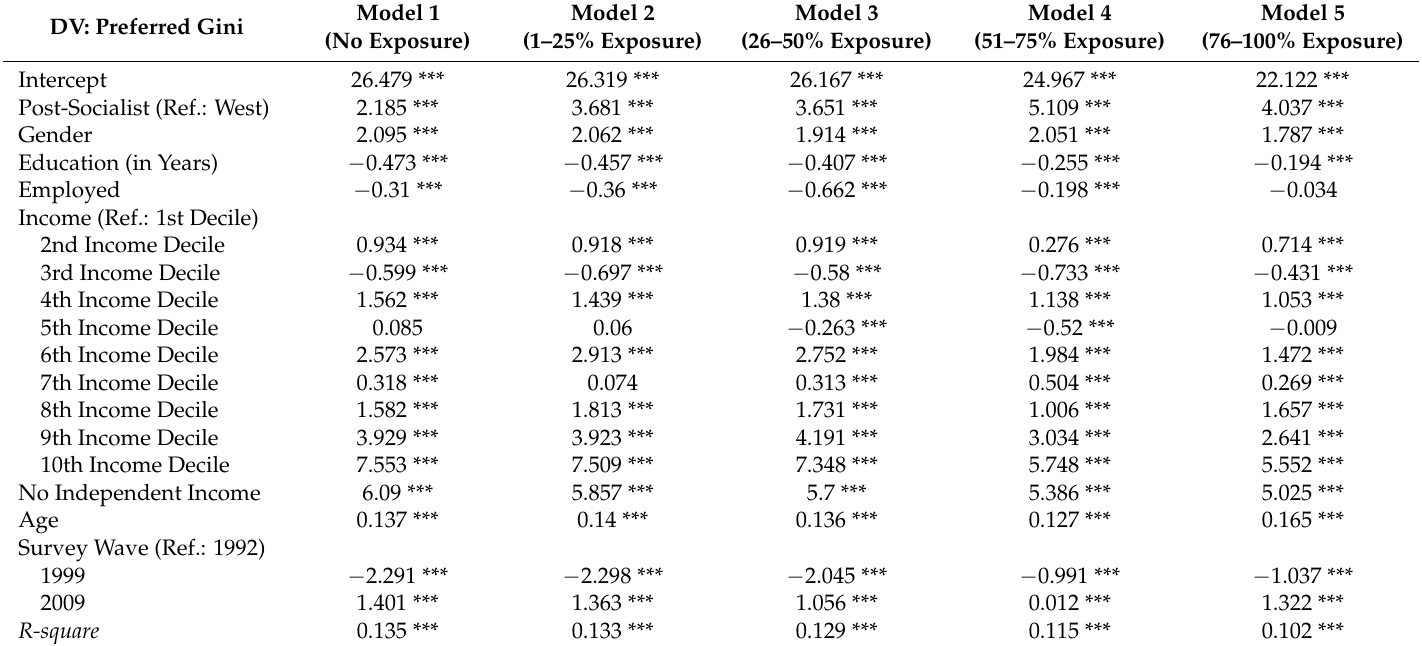
Table A8. Bootstrapped OLS regression models to explain the preferred Gini by exposure rate (corresponding with Figure 4b). DV: Preferred Gini